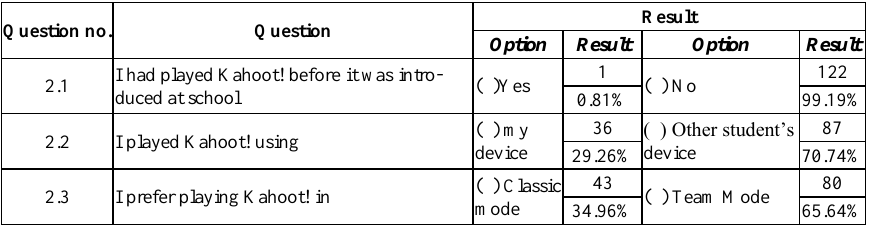
Table 6. Questionnaire Result, Part